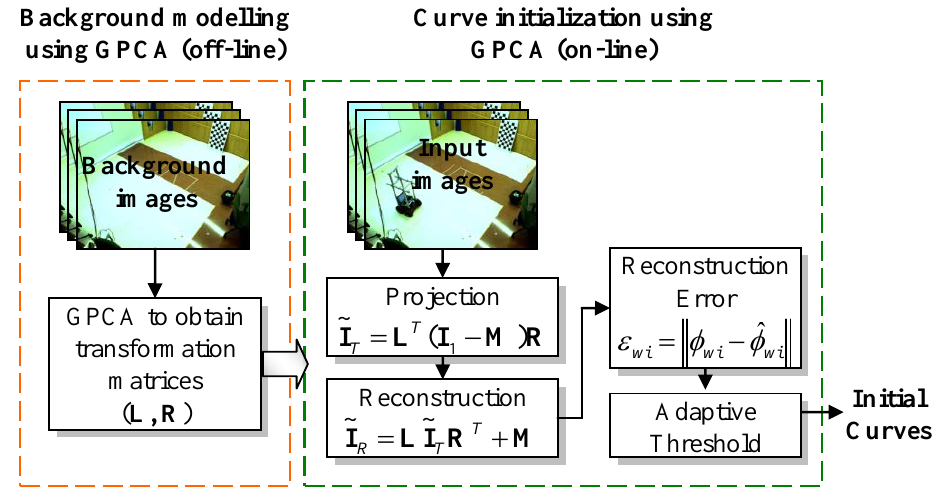
Figure 5. General block diagram of the proposed method for curve initialization using GPCA.